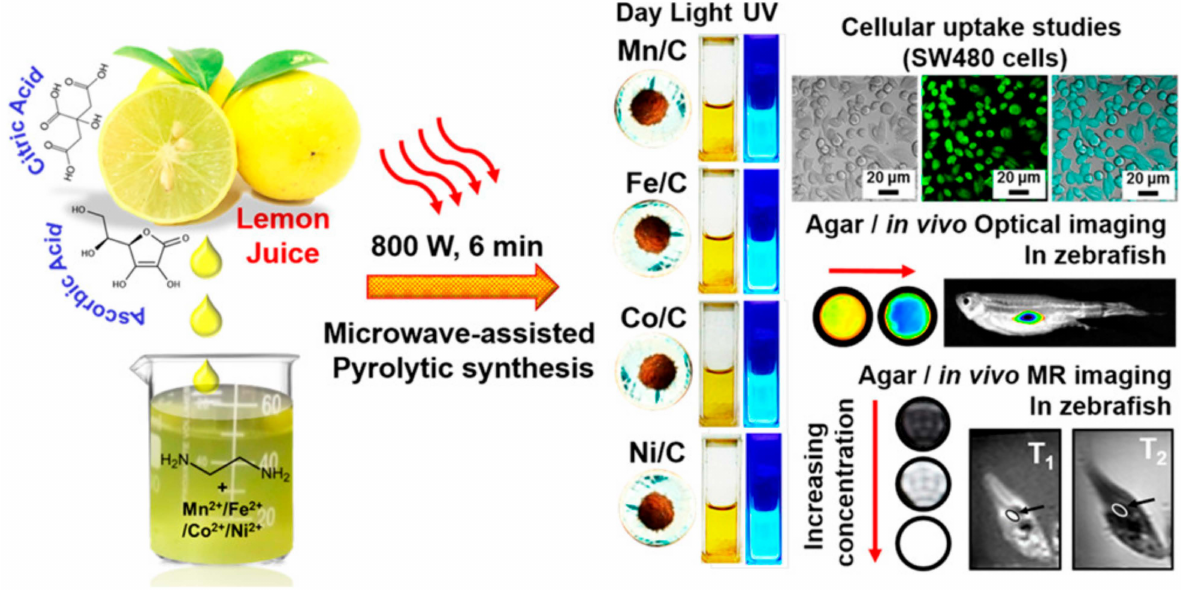
Figure 8. Microwave-assisted pyrolytic synthesis of EDA-functionalized TMCDs as possible nanoprobes for magneto-fluorescent bioimaging depicted schematically